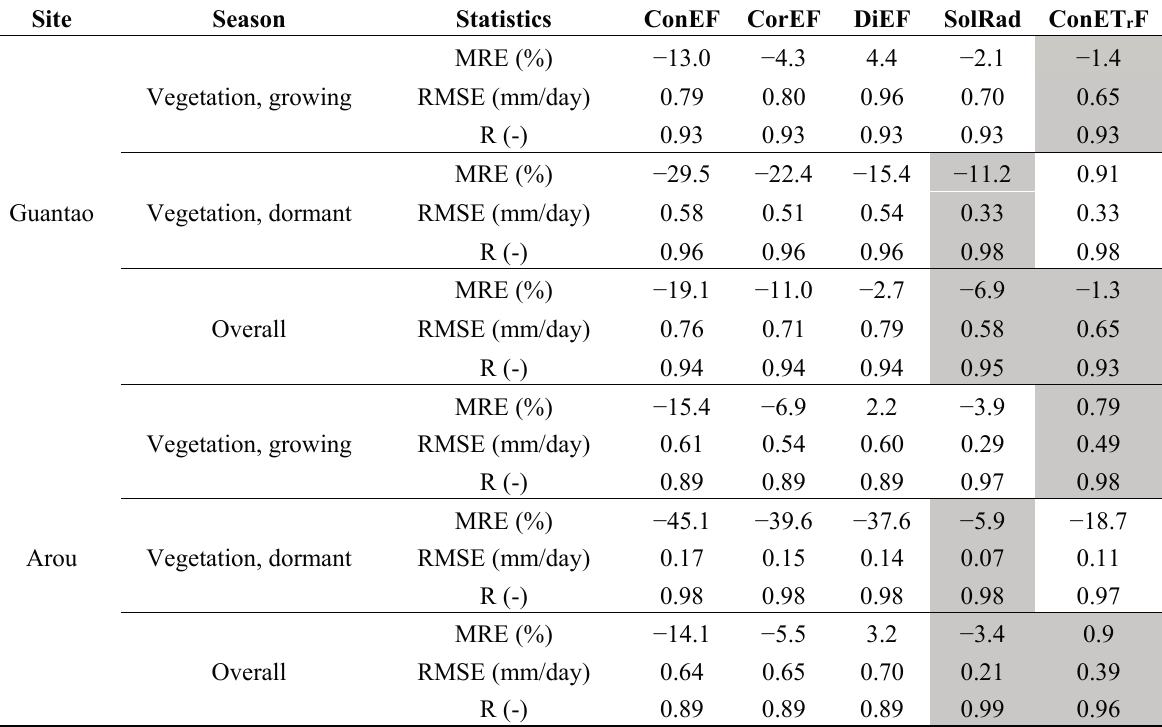
Table 4. The statistics of the five temporal upscaling methods at the Guantao and Arou